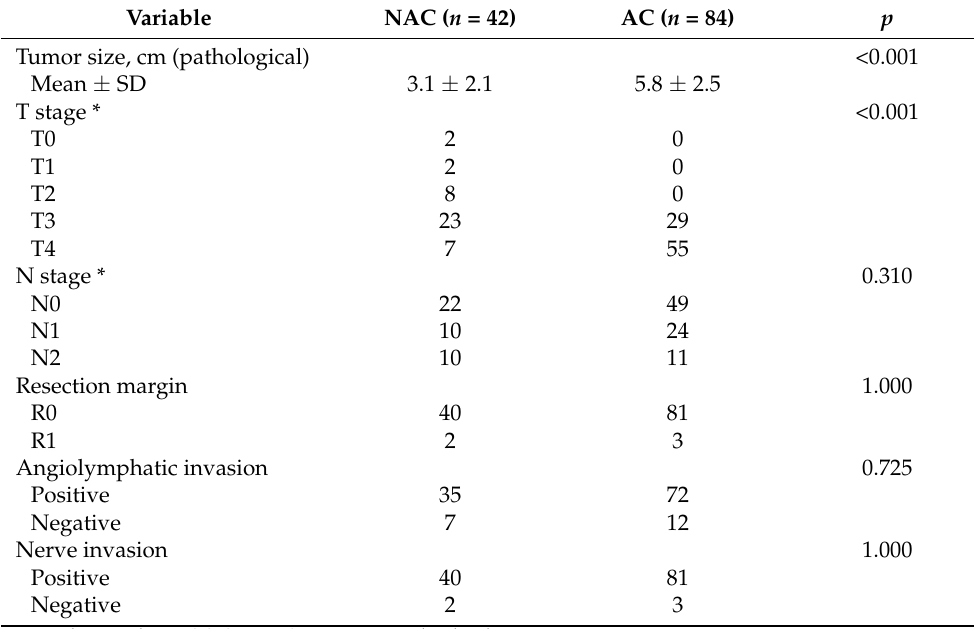
Table 4. Comparison of pathologic outcomes between the NAC and AC groups.